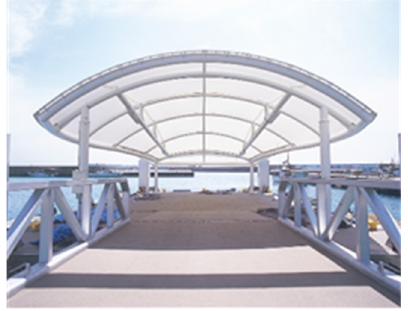
Figure 1. A vaulted free roof (provided by Taiyo Kogyo Corporation).